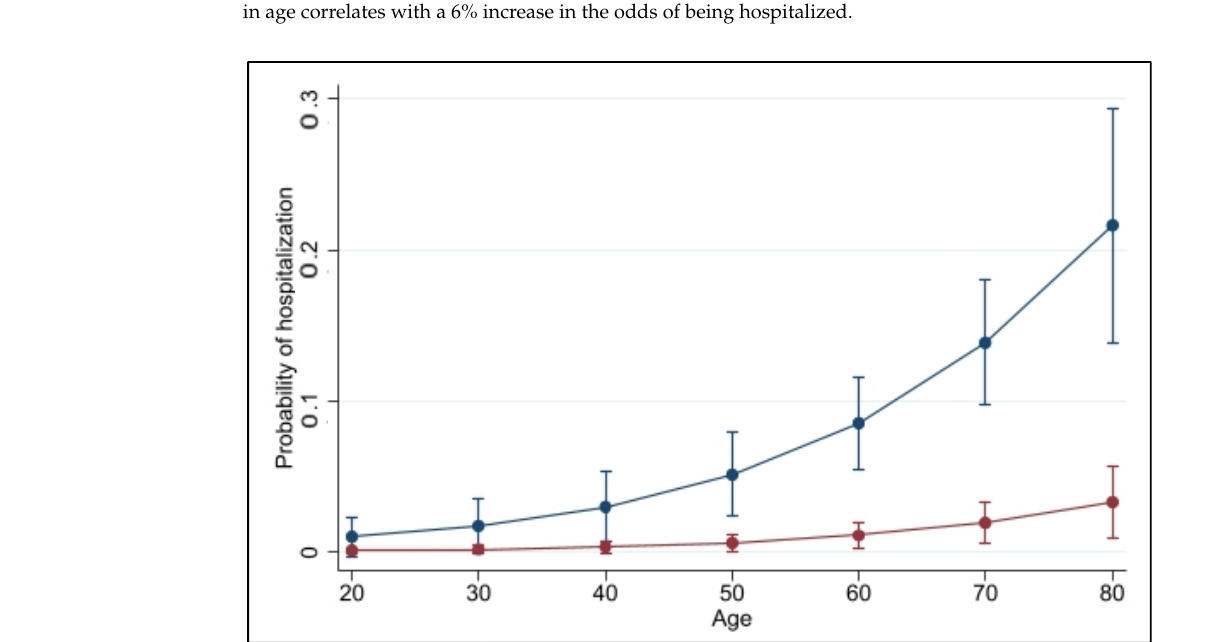
Figure 1. Marginal predicted probabilities of 28-day COVID-19-related hospitalization of outpatients treated with mAb by age and infection type: primary infection (blue curve) and breakthrough infection (red curve).